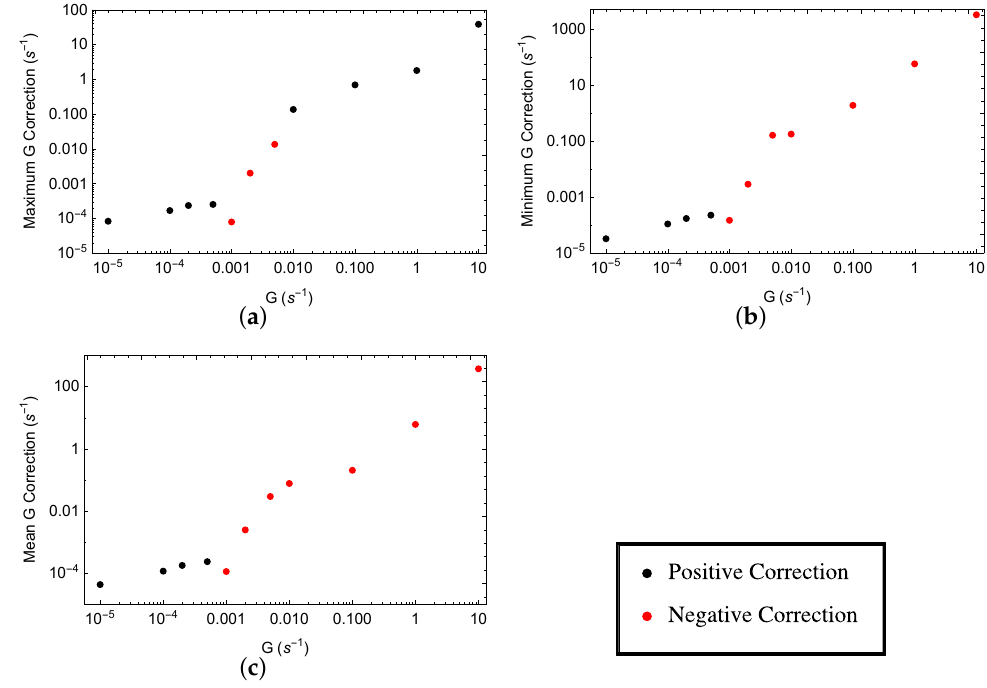
Figure 9. Maximum, minimum and mean nodal least-squares correction, ∆ G , for simulations over a range of G values, using output from the last two days of the 10.0-day simulation on the linear sloping domain. The magnitude of the correction is shown as the ordinate, while the color of the dot corresponds to the sign of the correction: positive corrections are shown in black, and negative corrections are shown in red. Observations are from the 2D CG ADCIRC code with G = 0.001 s − 1 . ( a ) Maximum; ( b ) minimum; ( c )